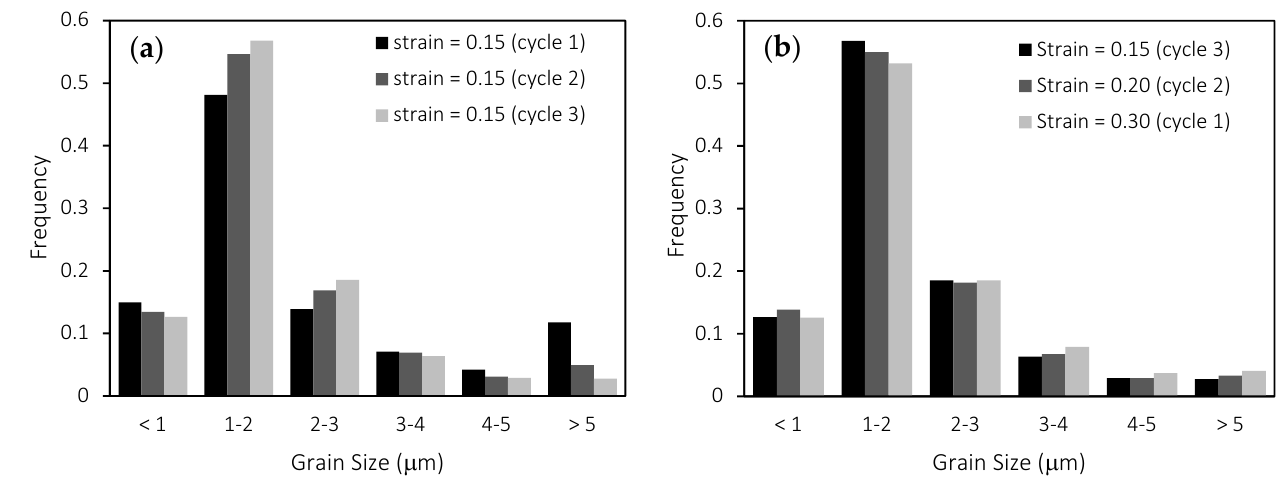
Figure 9. Grain size distribution for TMP samples: ( a ) scheme 3 ( ε = 0.15) and ( b ) Last cycle of schemes 1, 2, and 3 ( ε = 0.15, 0.20, 0.30).